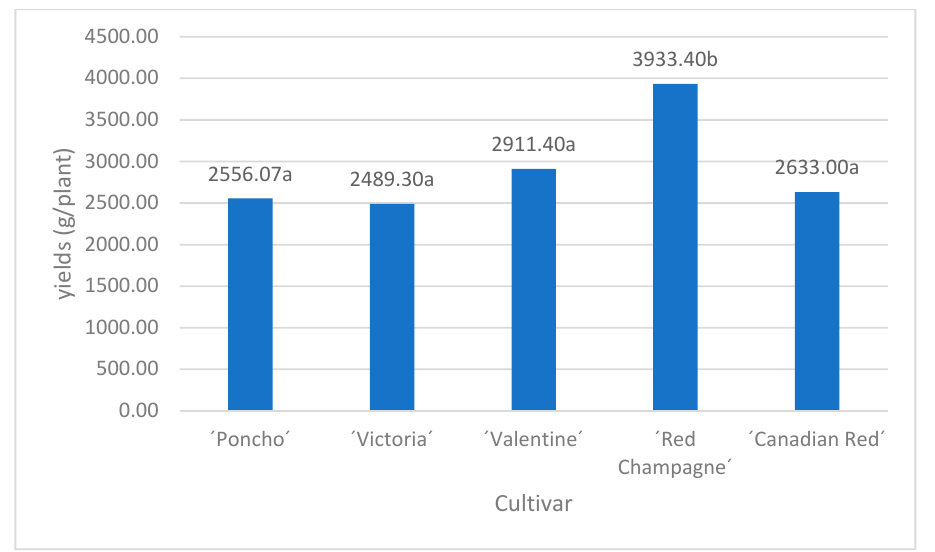
Figure 1. Effect of the experimental year and cultivar on the mean juice yield of all rhubarb cultivars. Abbreviations: PON, ´Poncho´; CRE, ´Canadian Red´; VAL, ´Valentine´; RCH, ´Red Champagne´;